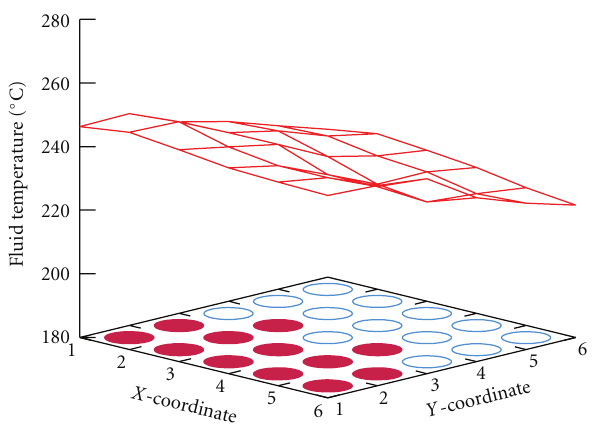
Figure 4: Measured outlet fluid temperature for Case 01-3233. Shaded rods operate at 4 times the power of the unshaded rods.